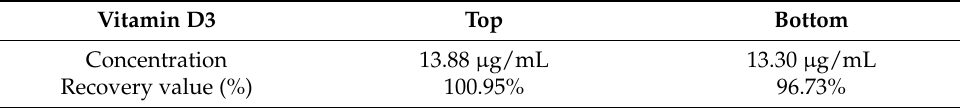
Table 3. Concentrations from top and bottom layer of liposomal vitamin D3.